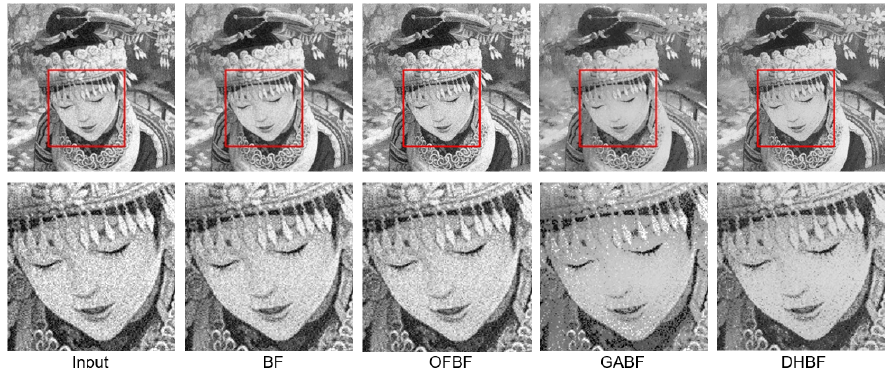
Figure 9. Visual comparison of the representative sample for image smoothing on Set14.